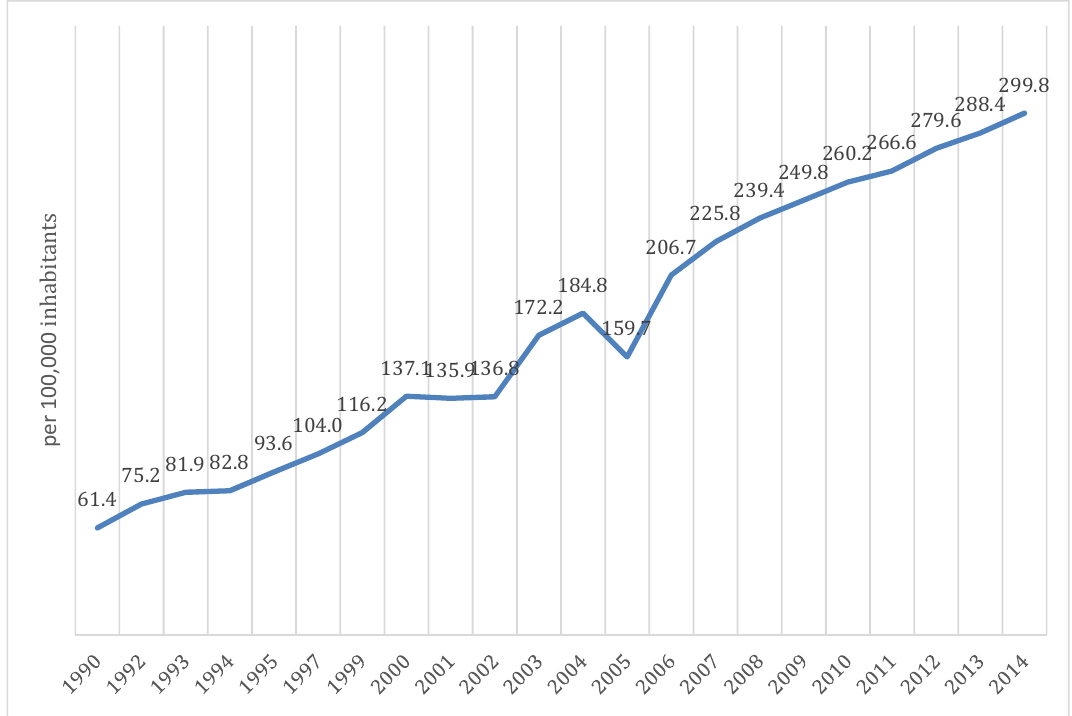
Figure 3: Growth of incarceration rates in Brazil, 12 month average (per 100,000